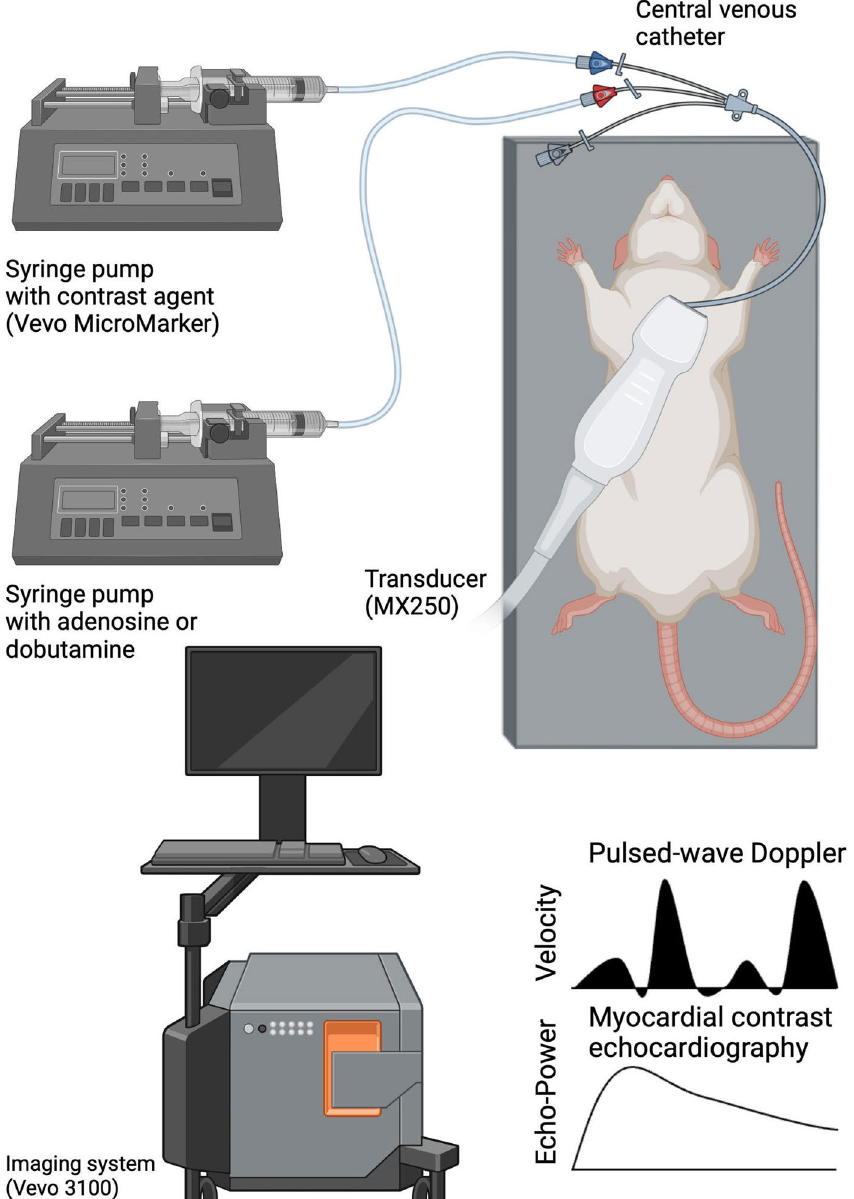
Fig. 1 Schematic experimental setup with a rat in the supine position. Coronary circulation was studied by pulsed-wave Doppler of the left coronary artery and by myocardial contrast echocardiography. Measurements were performed under three conditions: baseline, adenosine, and dobutamine (created with Biore nder.